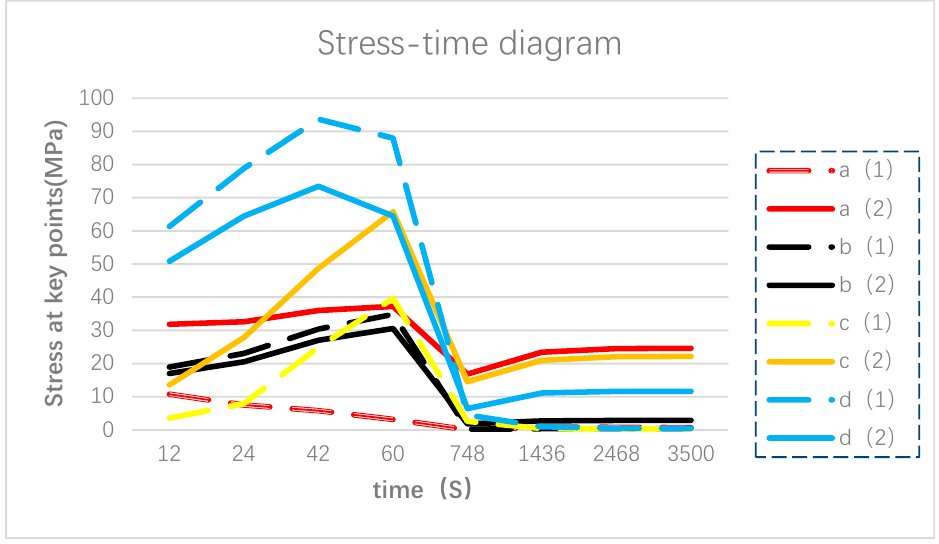
Figure 12. Comparison of the stress for the two types of constraints: 1: the first constraints; 2 the second constraints.